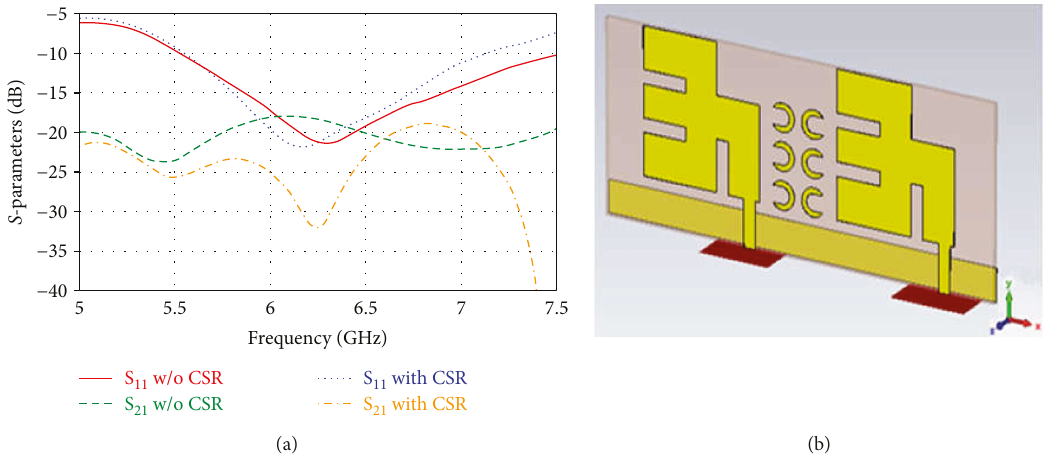
Figure 6: (a) MIMO system antennas with CSR matrix structure. (b) Simulated S -parameters with and without CSR matrix